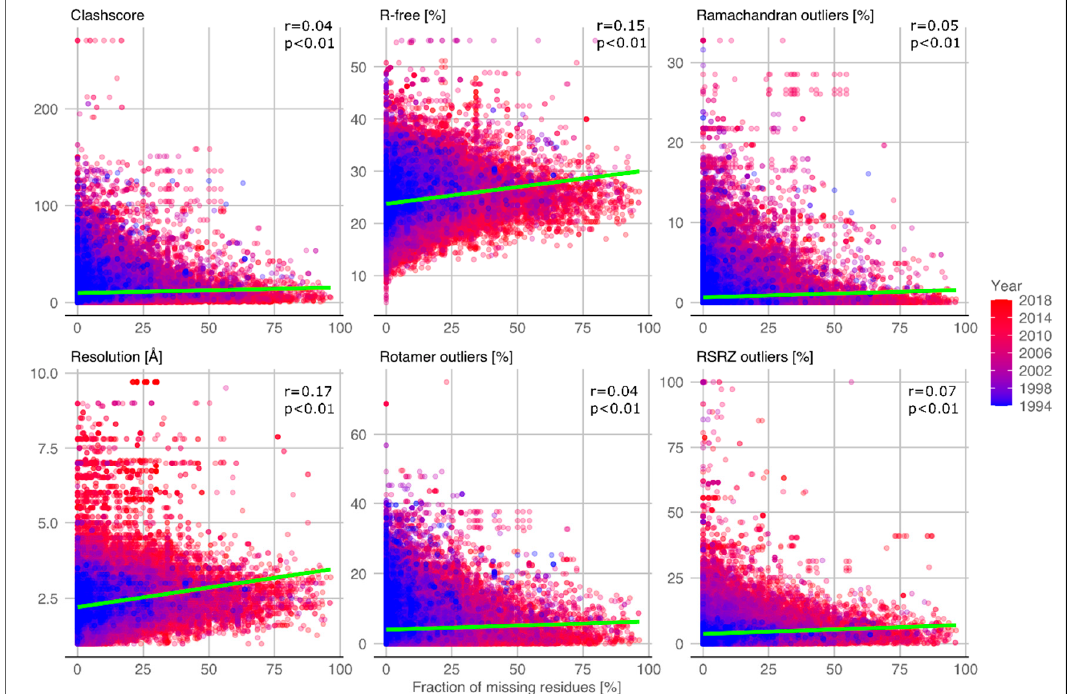
Figure 2. Scatter plots of different structure quality metrics and fraction of missing residues. On X-axis the fraction of missing residues calculated for the PDB chain (SEQRES). On Y-axes the different quality metrics corresponding specified on the title of each subplot. The color represents the year of deposition in the protein data bank (PDB). The green line represents the linear regression. Pearson’s correlation coefficients (r) and P-values (p) are shown for each subplot.